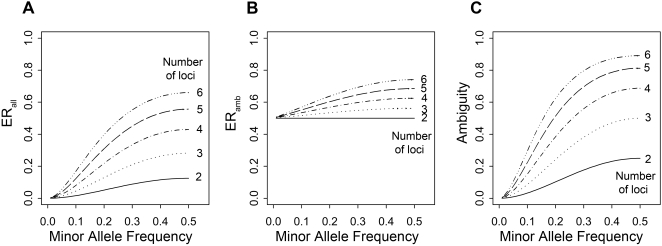
Error rate for varying number of loci and MAF under no correlation:A) ERall and B) ERamb and C) ambiguity analytically derived for abstract type c scenarios (2-6 loci, r = 0, equal MAF at each locus).